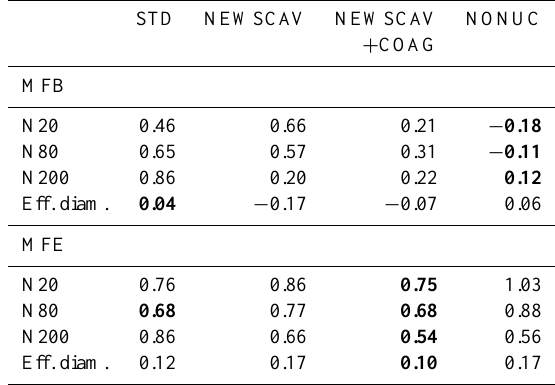
Table 5. Model–measurement mean fractional bias and mean frac- tional error (Eqs. 7 and 8) for N20, N80, N200, and effective diam- eter at Mt. Zeppelin (in reference to Fig. 6). Bias and error values closest to zero for each season are highlighted in